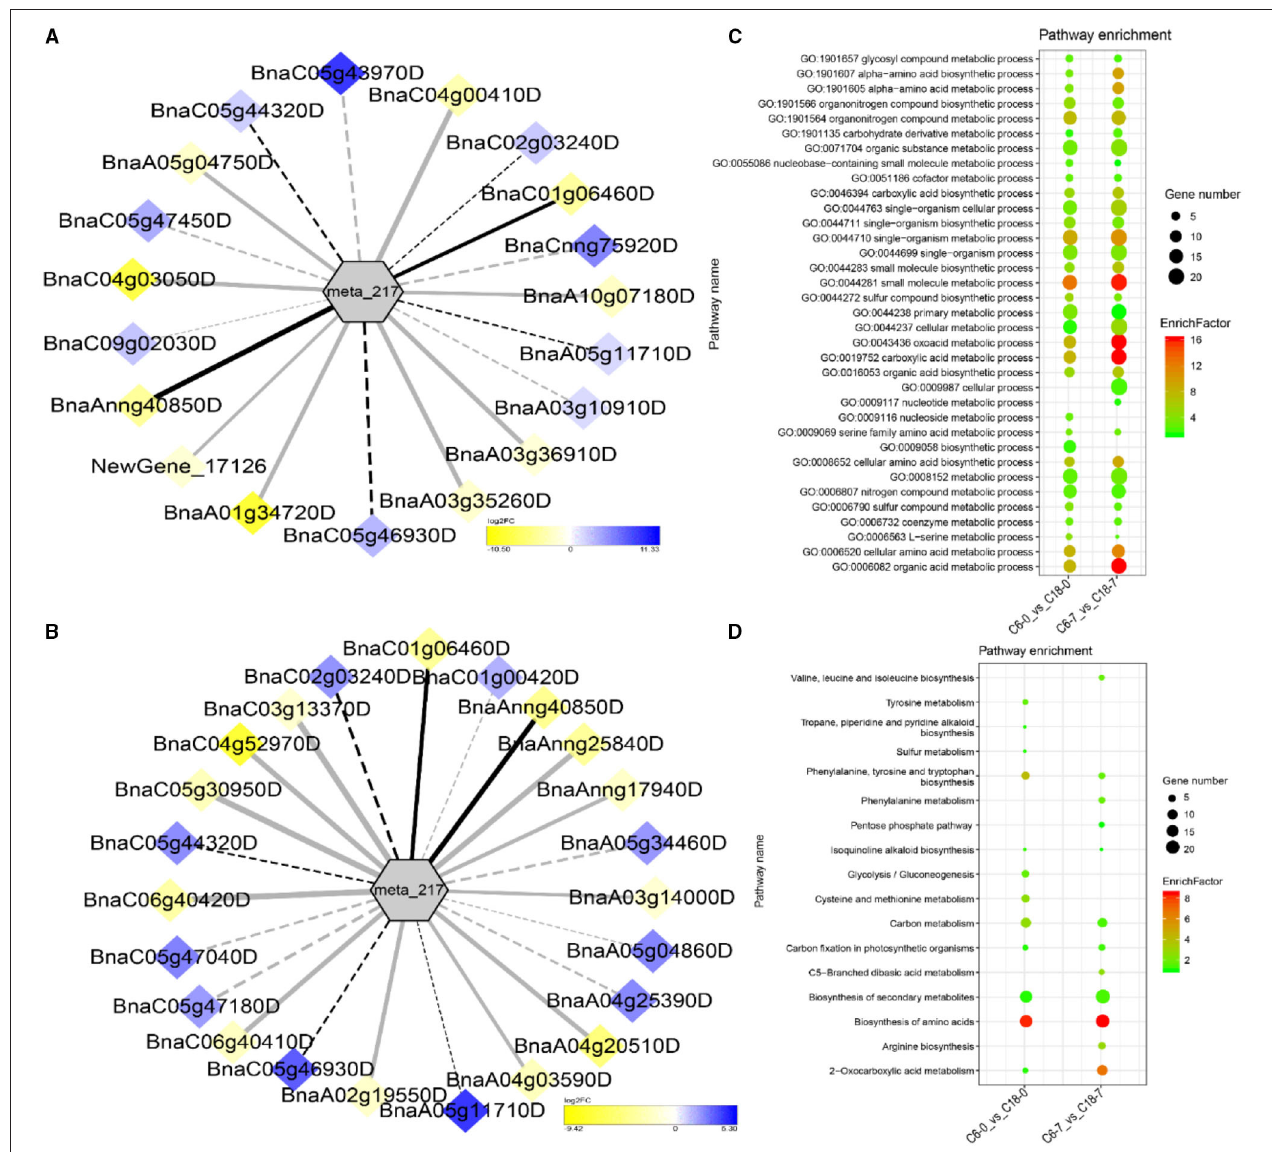
FIGURE 6 | Correlation network analysis between DAMs and regulatory genes related to CS. (A) Analysis of C6-0 vs. C18-0 and (B) analysis of C6-7 vs. C18-7. Log 2 FC of genes, in response to CS, are indicated in heatmap colors ranging from yellow (downregulated) to blue (u-regulated); log 2 FC values are indicated in the legend; the width of the connecting lines indicating the strength of the correlation; solid lines indicating the positive correlation and dashed lines indicating the negative correlation; black lines indicating the common genes and gray lines indicating the specific genes accumulated at that time point. (C,D) Scatter plots for the GO-BP enrichment analysis and KEGG pathway enrichment analysis of DEGs from G2, respectively. Only the highly enriched and most relevant terms and pathways are shown in the plots ( Q < 0.05.) –log 10 ( Q ) for enrichment